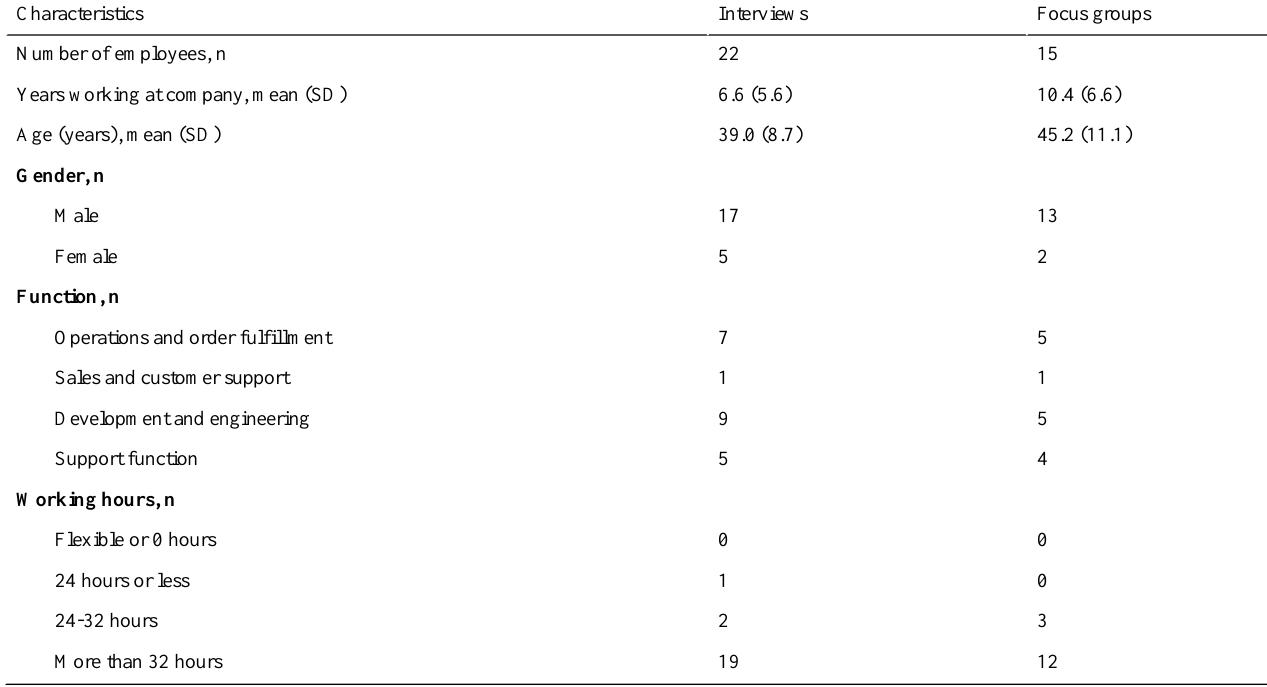
Table 1. Employee characteristics.